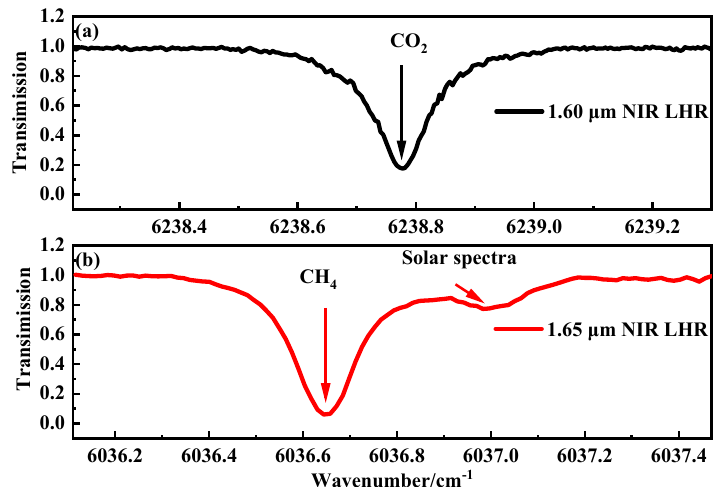
Figure 2. Atmospheric transmittance spectra measured by NIR LHR. ( a ) CO 2 at 6238.77 cm − 1 ; ( b ) CH 4 at 6036.65 cm − 1 .